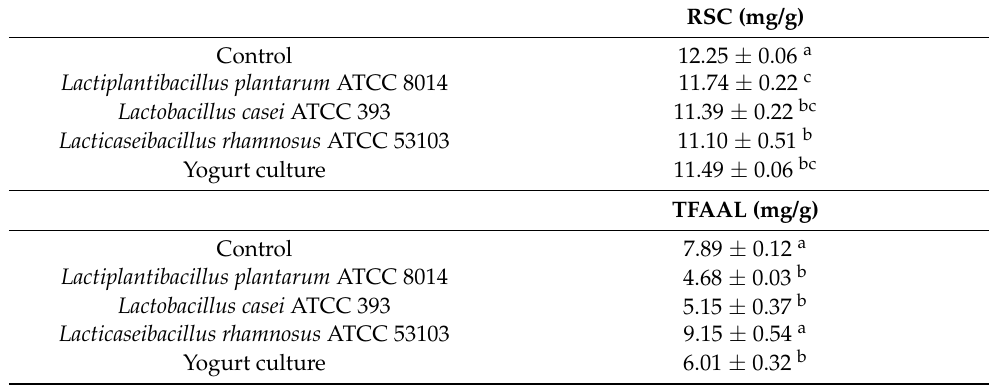
Figure 1. Lactic acid bacteria (LAB) counts. Values are means ± standard deviation of triplicate determinations. Means with different lowercase letters are significantly different between the strains at p < 0.05. Means with different uppercase letters are significantly different between days. Table 2. Changes in Reducing Sugars Content (RSC) and Total Free Amino Acids Level